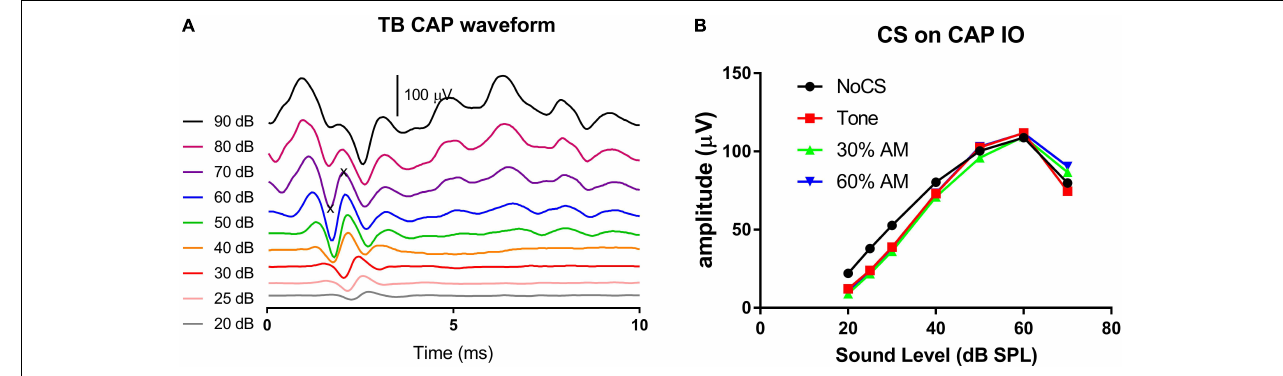
FIGURE 7 | CAP waveforms across sound levels (A) and the exemplary CS effect on CAP I/O functions (B) . Three CS signals (tones, AM with 30% and 60% modulation depths, respectively) were all presented at 75 dB SPL. They show a similar CS effect, which were larger at lower levels of tone bursts evoking CAP. The CAP amplitude was measured between “x” symbols (A)